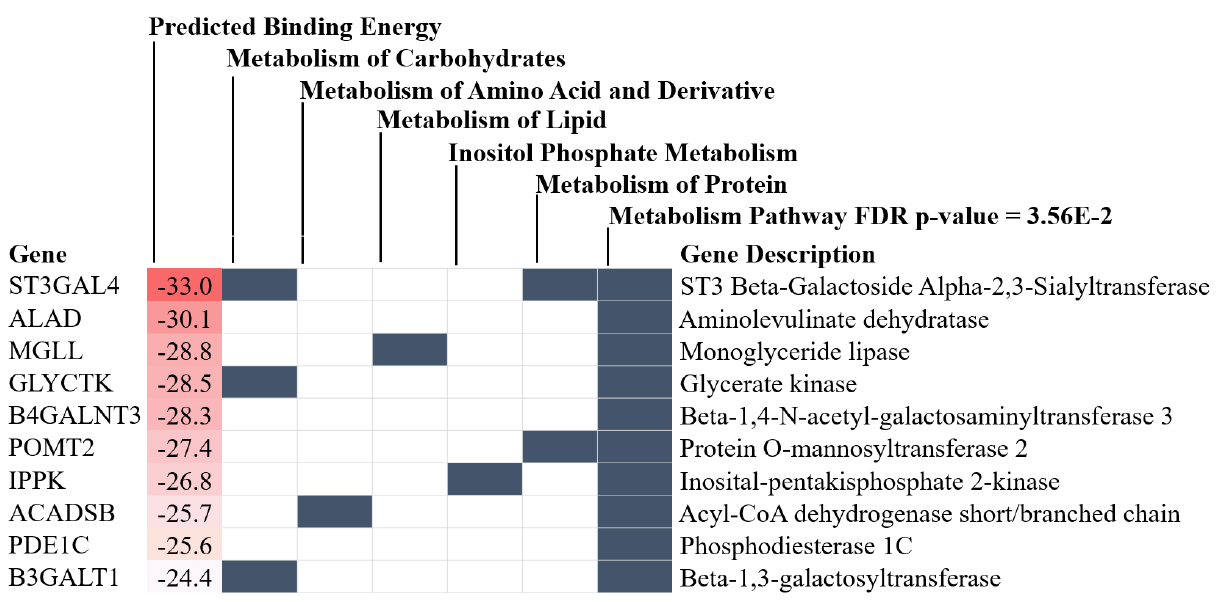
9 of 24 Figure 5. Heatmap illustration of microRNA arrays from the brains of mice with 24 h post-sham (sham), 24 h post-cecal ligation and puncture (CLP), and 120 h post-CLP (120 h post-sham group is